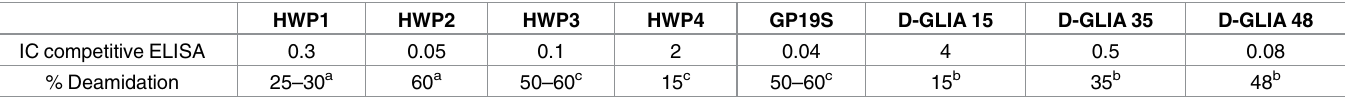
Table 1. Relative abundance of deamidated sequences detected by mDG1 in deamidated protein fractions. Six concentrations (6 ng/mL-20 μ g/mL) of native or deamidated samples were analyzedwith a competitive mDG1 ELISA. For each sample, IC 50 , i.e., the concentration that inhibitedhalf of the maxi- mum binding,was